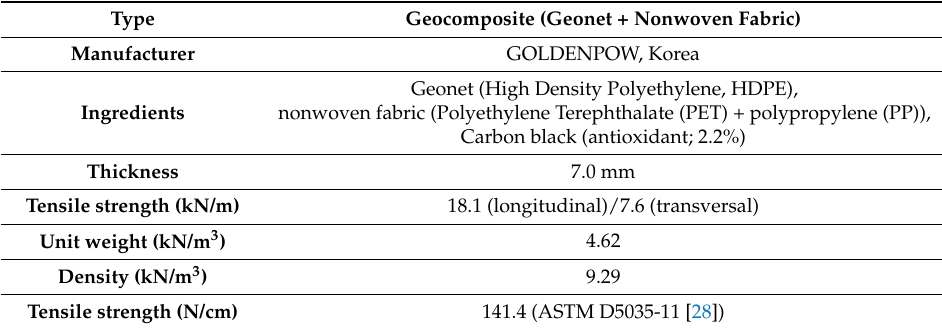
Table 2. Specifications of the